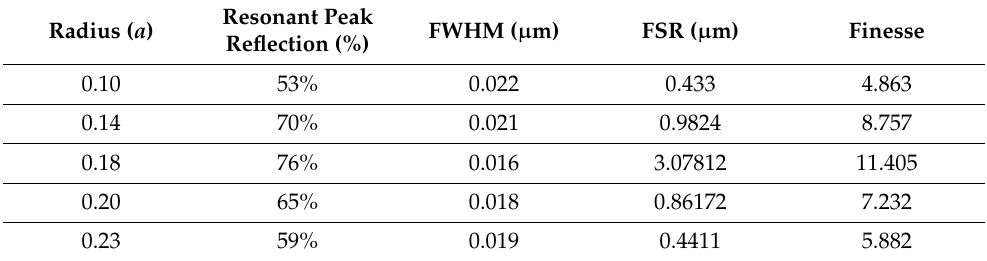
Table 1. Spectral parameters of DRB-PhCs structure used to evaluate its spectral